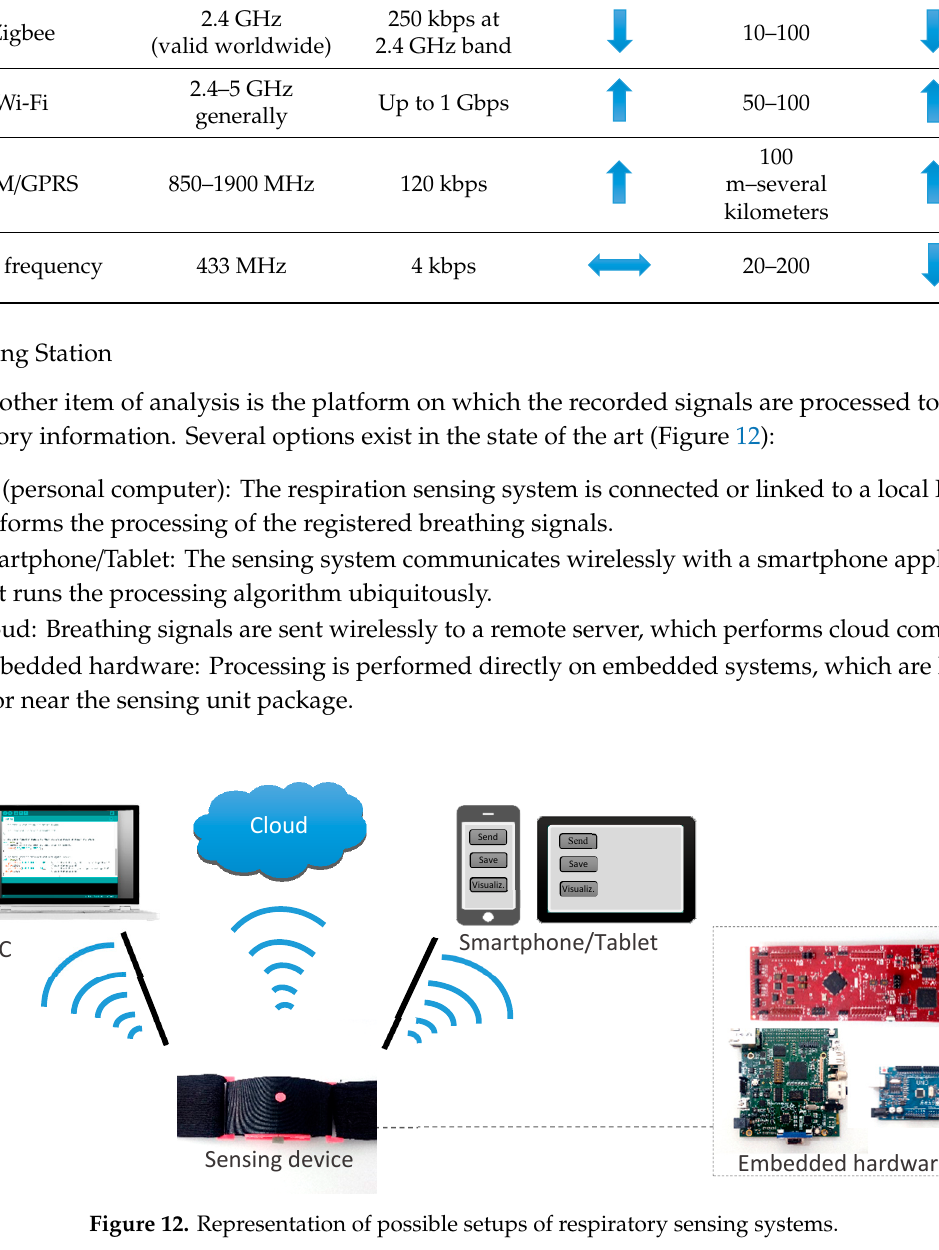
Table 3. Comparison of the main transmission technologies used in respiratory monitoring systems [237].